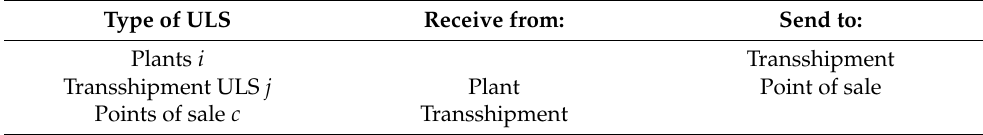
Table 1. Relationship of flows between ULS.